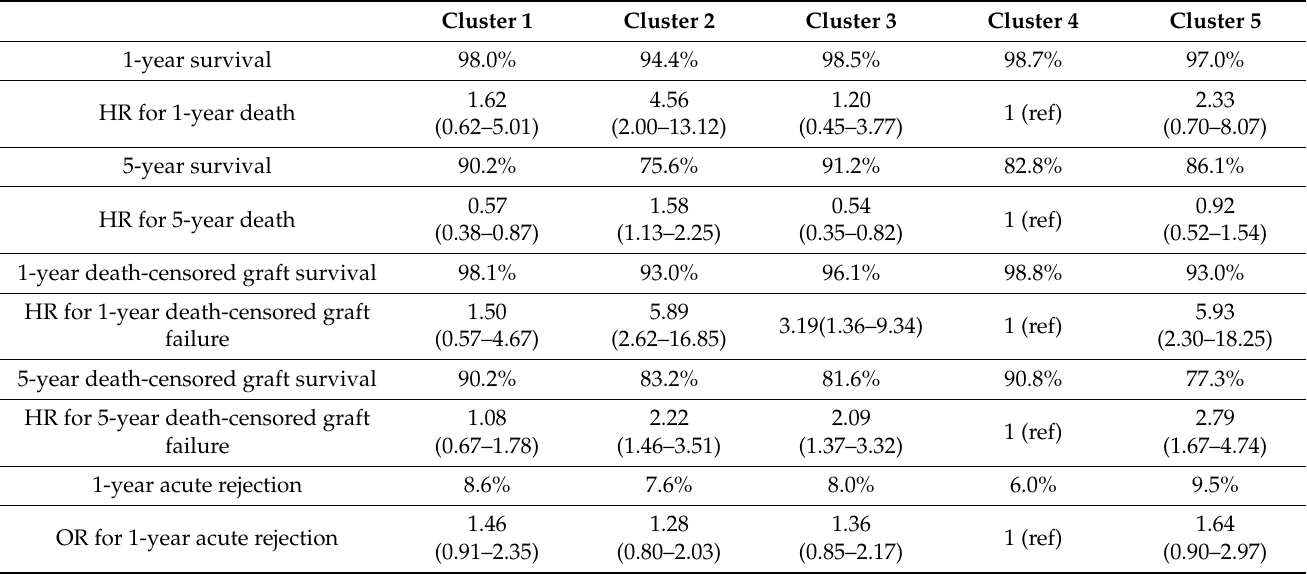
Table 2. Post-transplant outcomes according to the clusters of morbidly obese